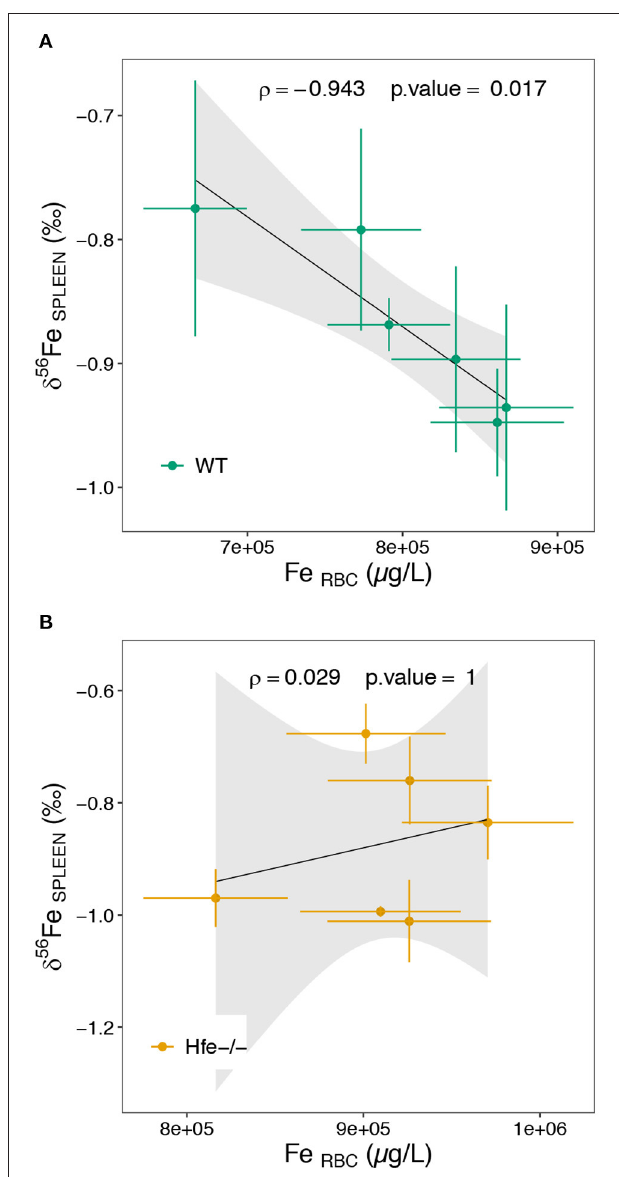
FIGURE 4 | Scatterplot of the spleen Fe isotope composition as a function of the erythrocytes Fe concentration for the WT (A) and H fe -/- (B) mouse groups. RBC stands for erythrocytes. The ρ coefficient and P -values of the Spearman test with associated significance (*** P < 0.001, ** P < 0.01, * P < 0.05) are